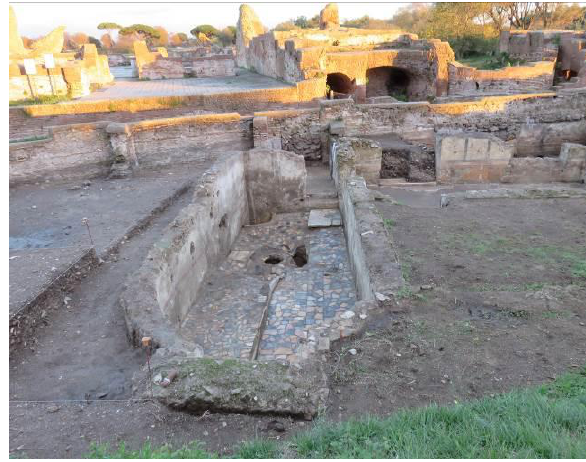
Fig. 2. Mithraeum of Multicoloured Marbles, Ostia Antica,